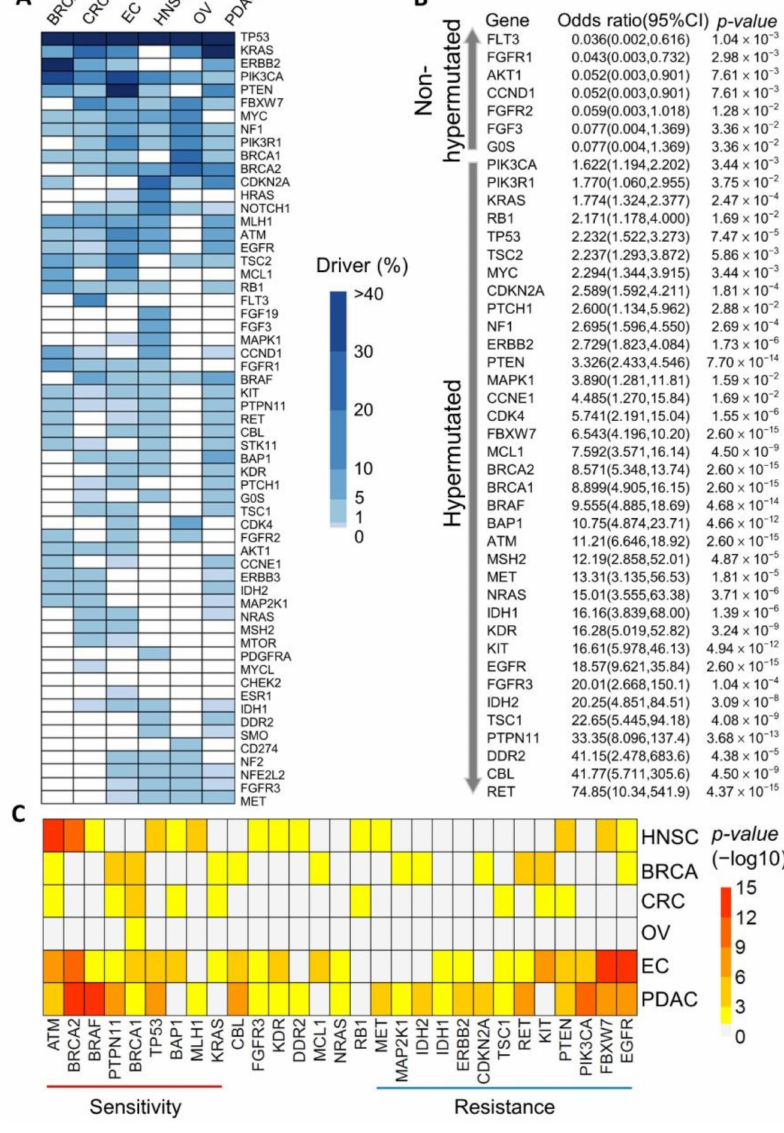
Figure 1. Driver mutations in hypermutated cancers. ( A ) The spectra and percentages of driver mutations in six cancer types: breast (BRCA), colorectal (CRC), endometrial (EC), oral (HNSC), ovarian (OV), and pancreatic (PDAC). ERBB2 driver mutations were the most common mutations in BRCA; KRAS driver mutations were the most common in PDAC and CRC; BRCA1 and BRCA2 driver mutations were the most common in OV; CDKN2A and HRAS driver mutations were the most common in HNSC, and PTEN genetic mutations were the most common in EC. ( B ) Genetic driver mutations in all 533 patients with hypermutated and nonhypermutated cancers. p -values were calculated using an odds ratio with a false discovery rate (FDR) correction, and a p -value < 0.05 was considered statistically significant. There are seven genes with odds ratios < 1 in patients with nonhypermutated cancers. The other genes have values > 1 in patients with hypermutated cancers. ( C ) Mutation-associated sensitivity or resistance to immunotherapy. Heatmap of hypermutation- associated genetic driver mutations in six cancer types. Genes that were significant in at least two cancer types are shown. Most hypermutated EC and PDAC patients carried EGFR , PIK3CA , and FBXW7 genetic mutations, and most hypermutated HNSC, EC, and PDAC patients carried the ATM , BRRCA2 , and BRAF genetic mutations. The p -value was calculated by an odds ratio and adjusted by FDR